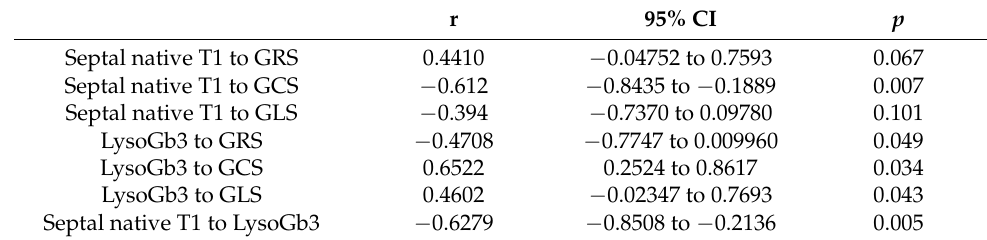
Table 5. Correlations of strain values, LysoGb3 and native T1 in LysoGb3+ patients.